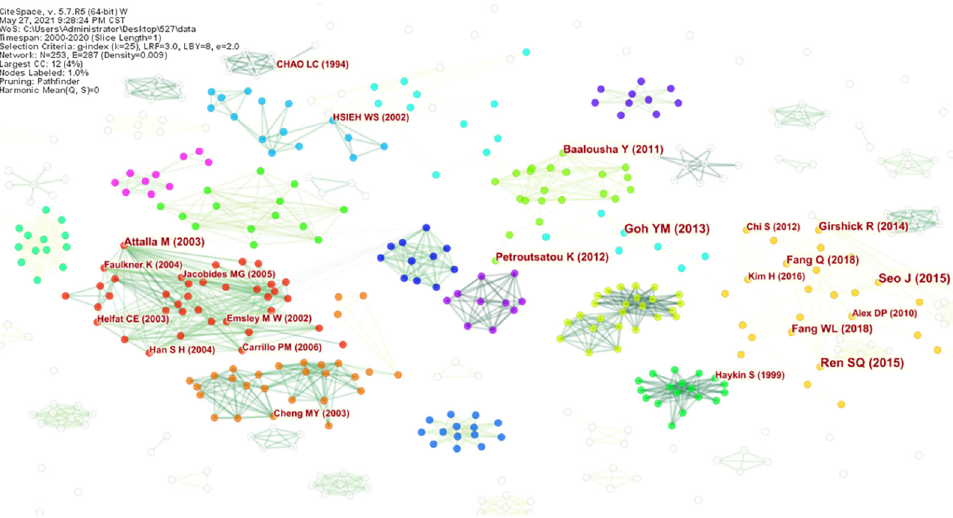
Figure 7. Document co-citation network of ANN in CM [15,28–137].